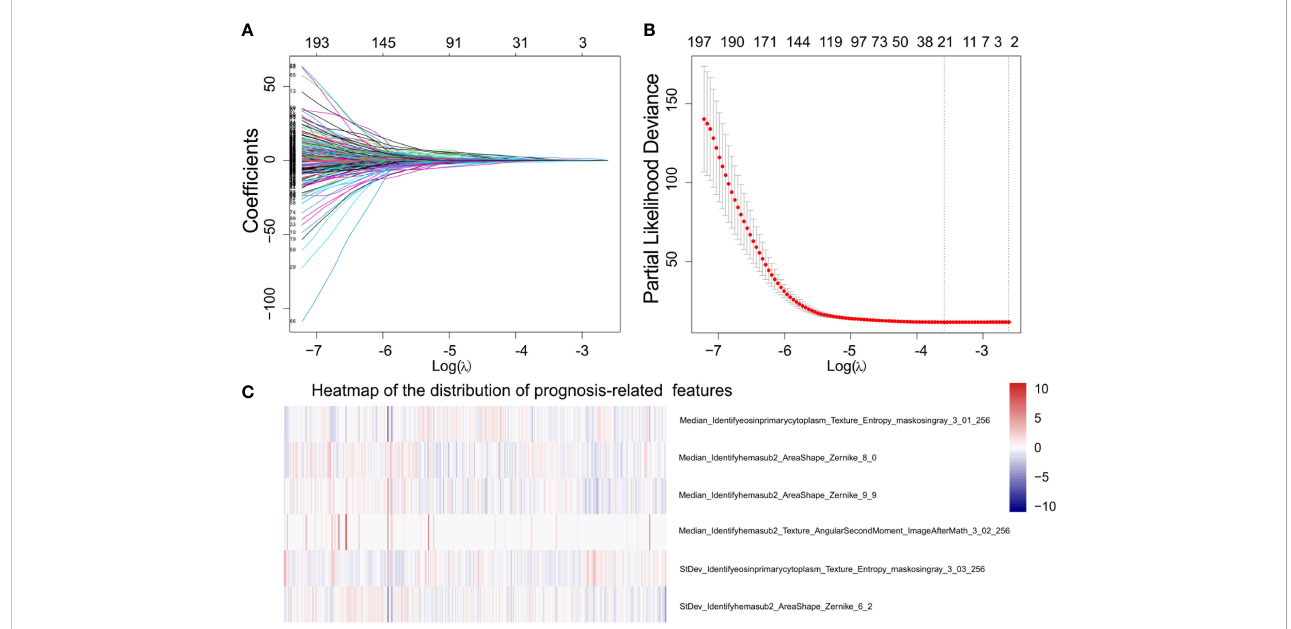
FIGURE 3 Demonstration of the prognosis-related morphological feature selection process using the Lasso-Cox model. (A) The pro fi le of coef fi cients in the model at different levels of L1 penalization plotted against the log(lambda) sequence. (B) The minimum standard (the left line) was adopted to obtain the value of the super parameter l by 10-fold cross-validation with the criteria of partial likelihood deviance. (C) Heat map that shows the distribution of prognostically signi fi cant features.